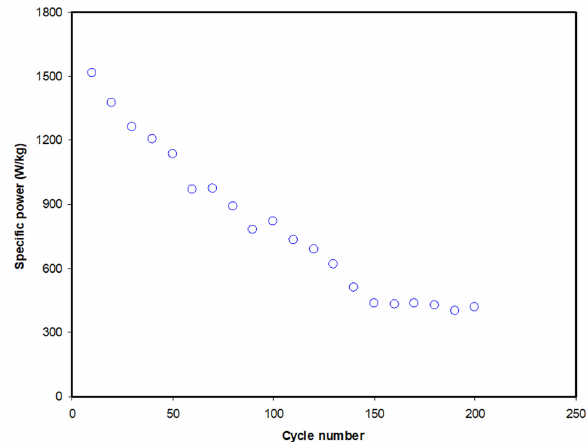
Figure 11. Specific power of the EDLC at 0.5 mA/cm 2 for 200 complete cycles.